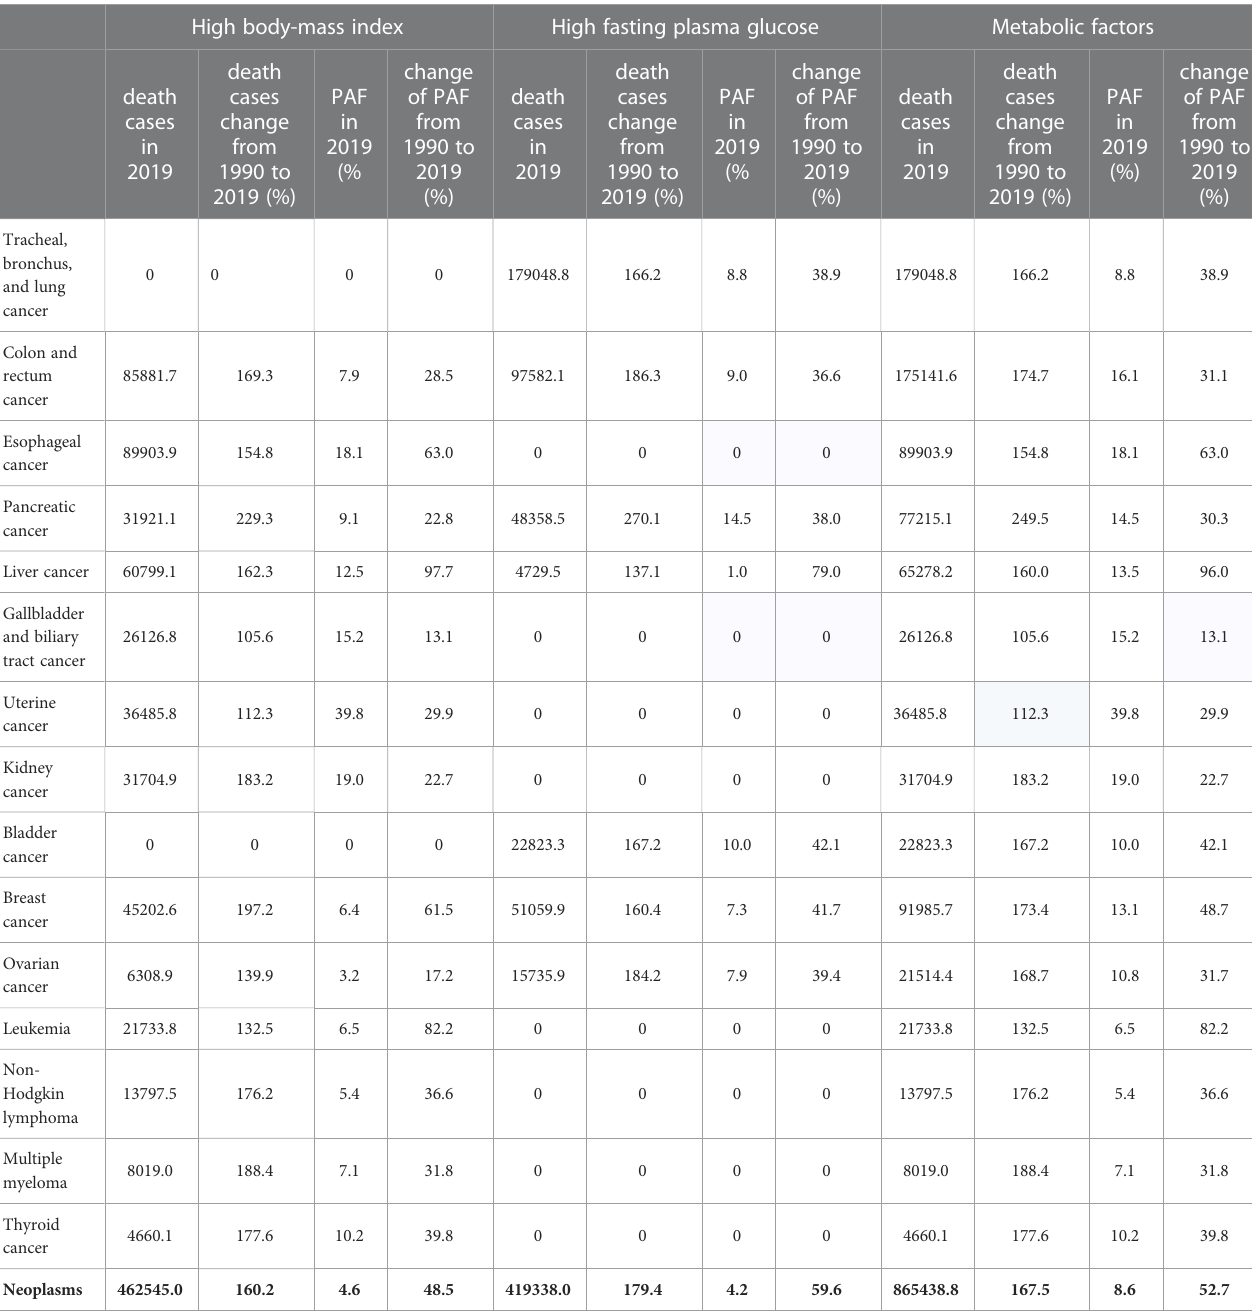
TABLE 2 Population attributable fraction of cancers by metabolic factors in 2019, and changes from 1990 to 2019. High body-mass index High fasting plasma